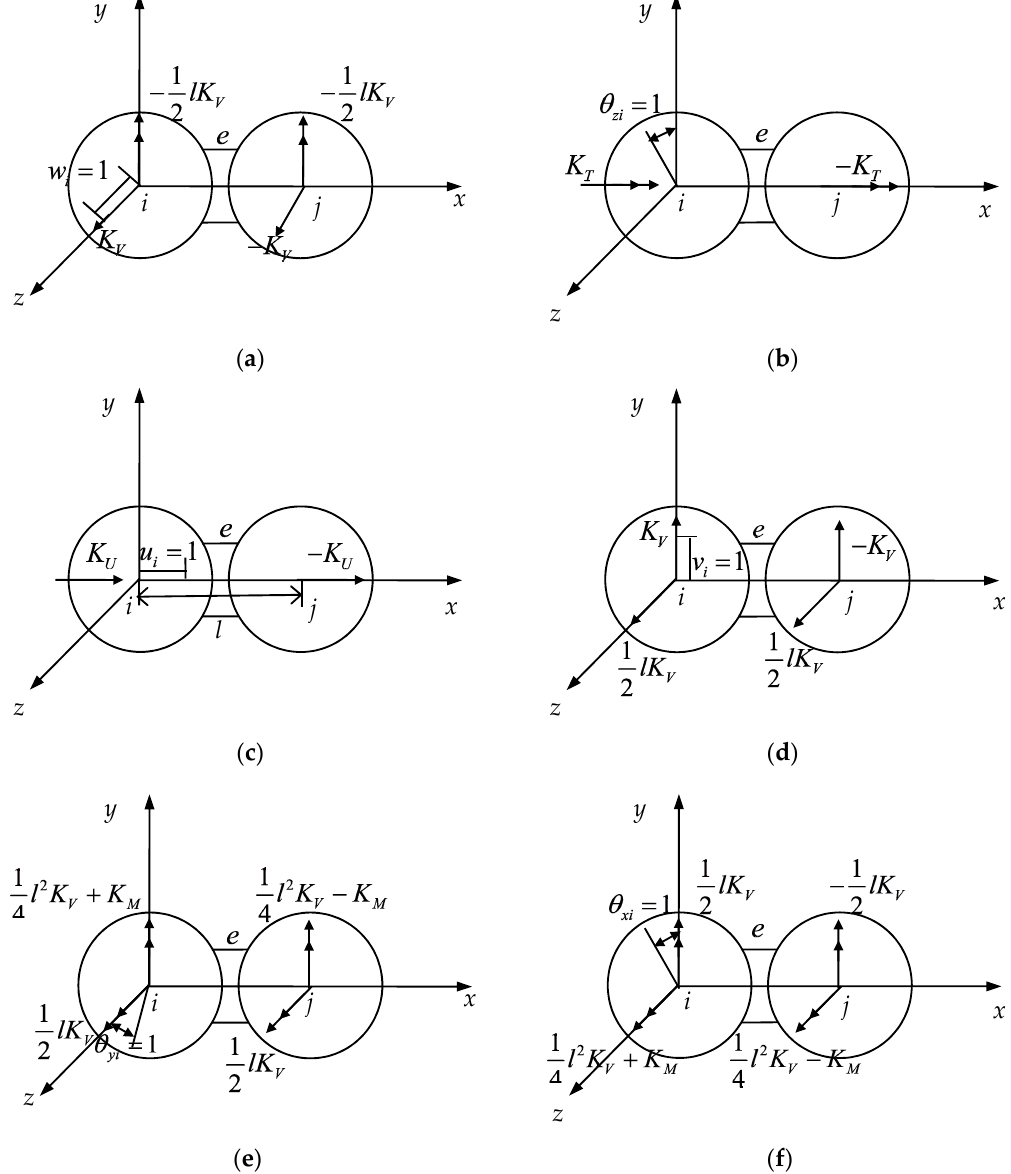
Figure 6. Unit node force caused by unit node displacement.